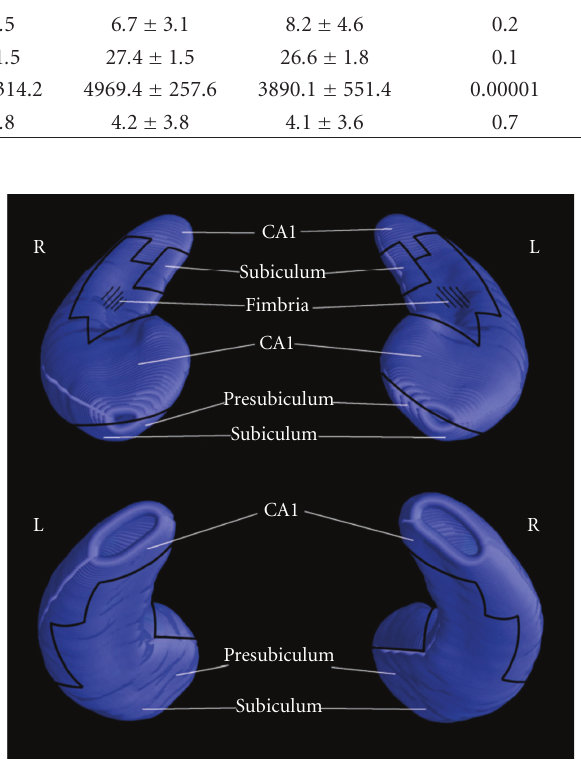
Figure 1: Cytoarchitectonic subregions mapped on blank MR- based models of the hippocampal formation of a healthy